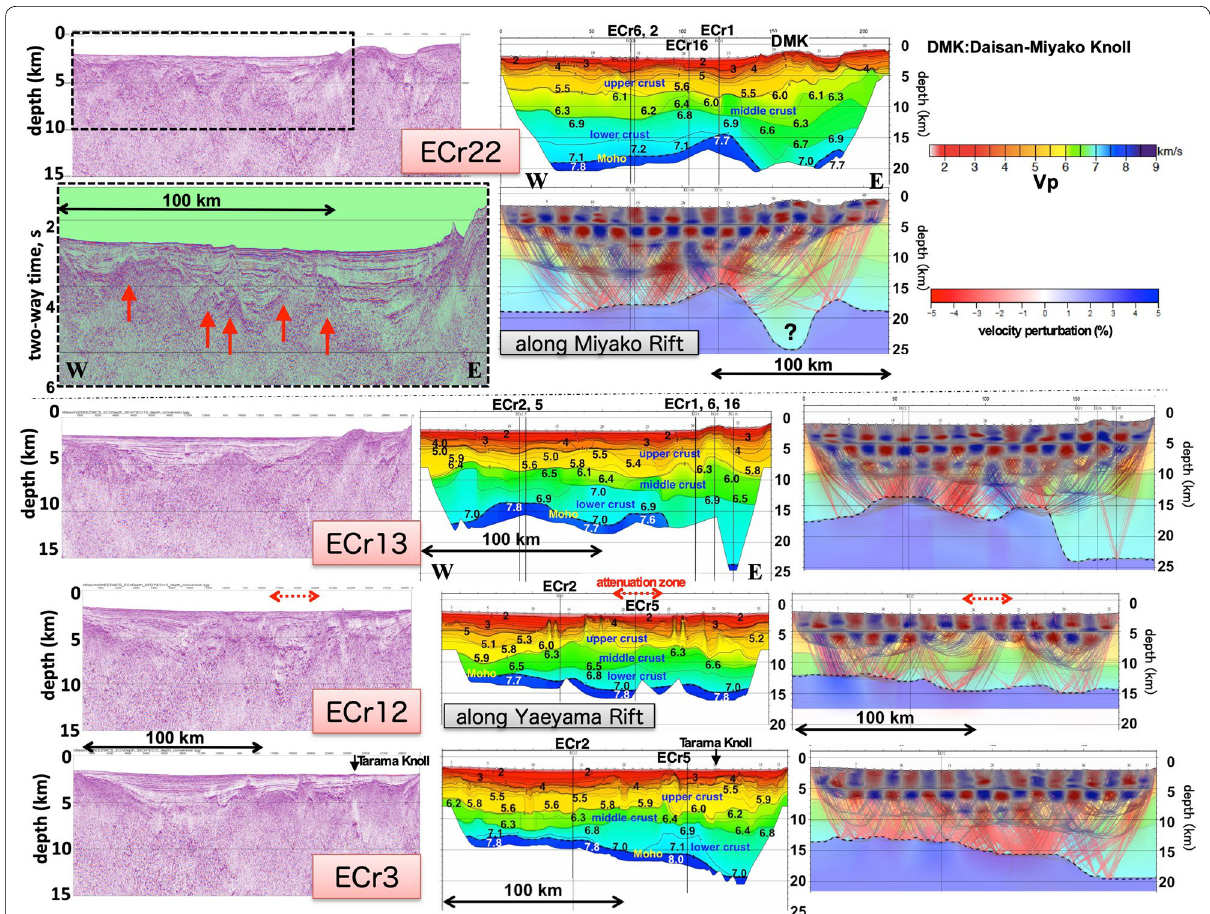
Fig. 15 MCS depth sections, Vp models, and checkerboard test results with ray coverage for ECr22, ECr13, ECr12, and ECr3. The ray paths correspond to manual readings on the observed record sections for each seismic line. Noticeable intrusions are shown by up-arrows in the MCS time section for ECr22. The strong attenuation zone beneath the Yaeyama Rift occurs at least within the upper and lower crusts beneath the double-headed arrow along